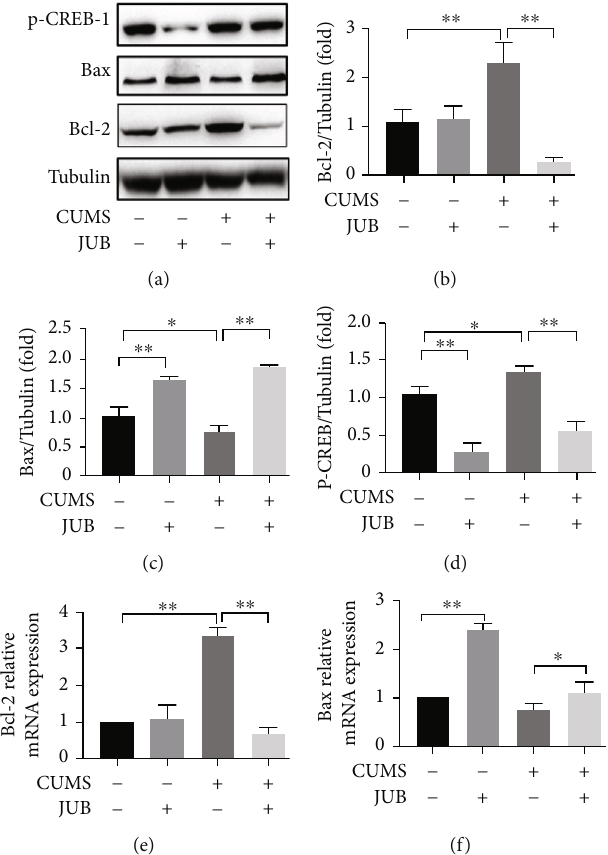
Figure 6: E ff ect of JUB and CUMS on in fl ammatory and apoptosis-related gene expression in the transplanted LLC tumors. (a) Protein expression bands of tumor tissues. (b – d) Statistical analysis of protein expression of p-CREB-1, Bcl-2, and Bax. (e – f) mRNA expression of transplanted LLC tumors. Data are mean ± SD ( n = 8/group ). ∗ P < 0 : 05and ∗∗ P < 0 : 01